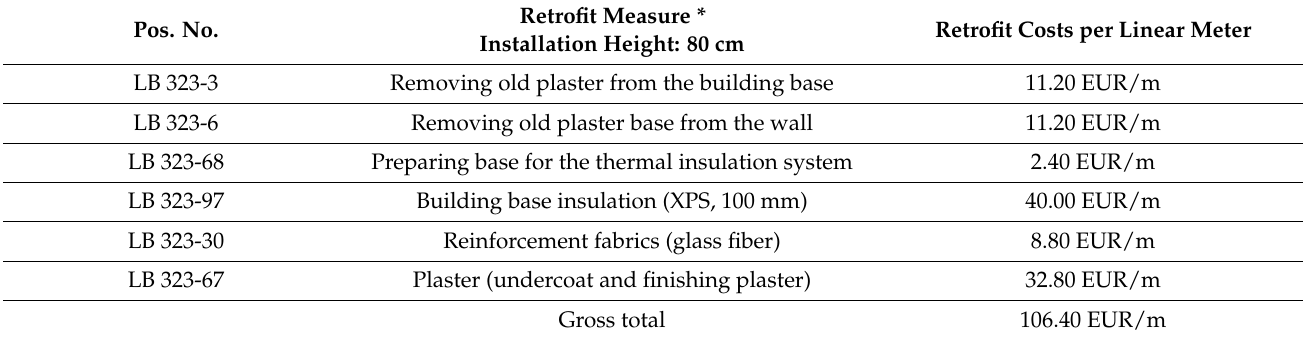
Table A4. Retrofit components and costs of the thermal bridge retrofit of a basement ceiling slab [38,39]. Pos. No.